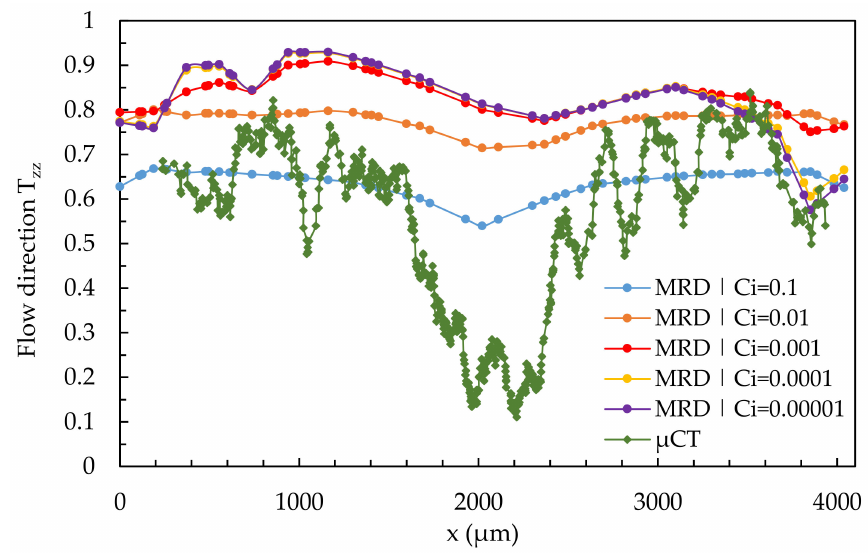
Figure 15. Quantitative results of fiber orientation in T zz -direction over the cross-section characterized by µ CT and predicted by the 3D mesh under variation of the fiber interaction coefficient C i at location